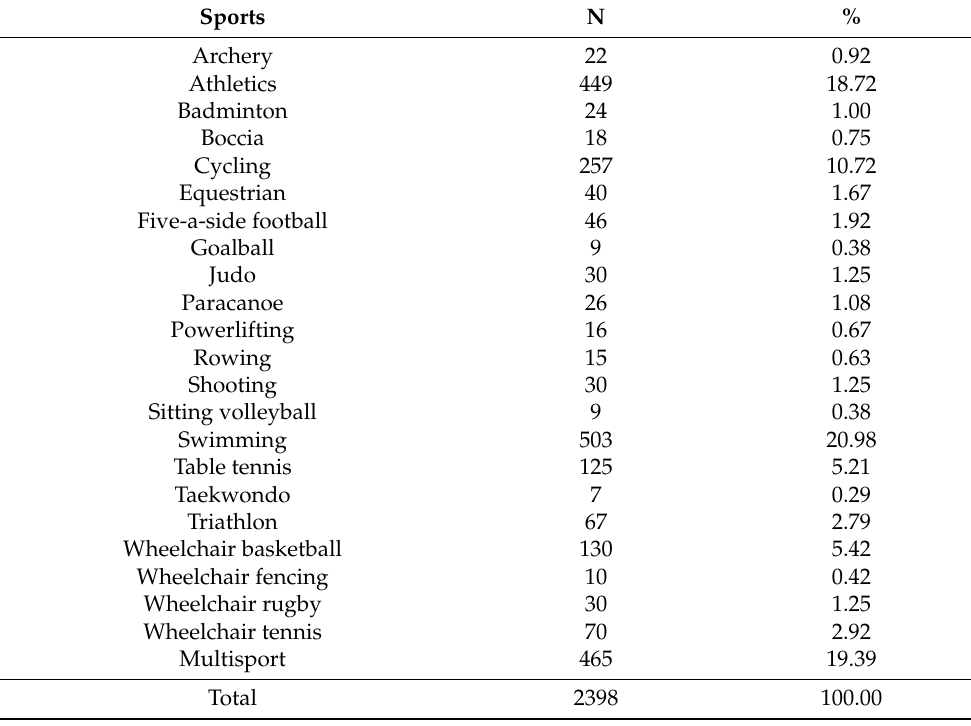
Table 4. Paralympics sports